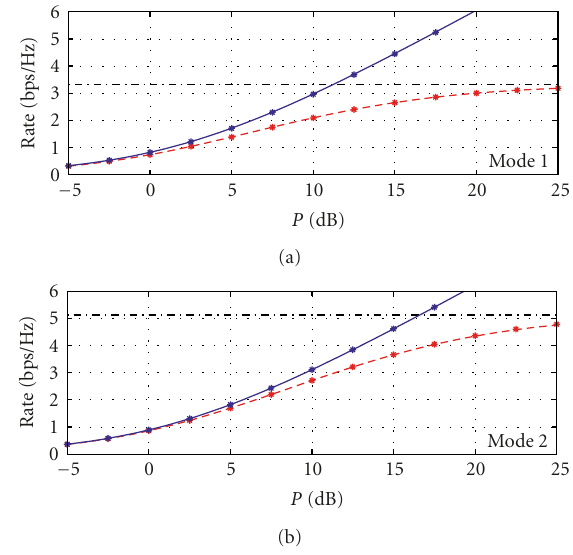
Figure 1: Achievable rate per beam for two-antenna mode 1 and 2 in the presence of Rayleigh fading and constant Tx power. Solid curves refer to TDMA-RR when total Tx power is normalized to P/ 2. Dashed curves refer to achievable rate per beam for spatial multiplexing with no CQI, and dash-dotted curves represent the asymptotic upper bound behavior presented in (22). In all cases, point values (“ ∗ ”) were simulated to verify the analytical results.